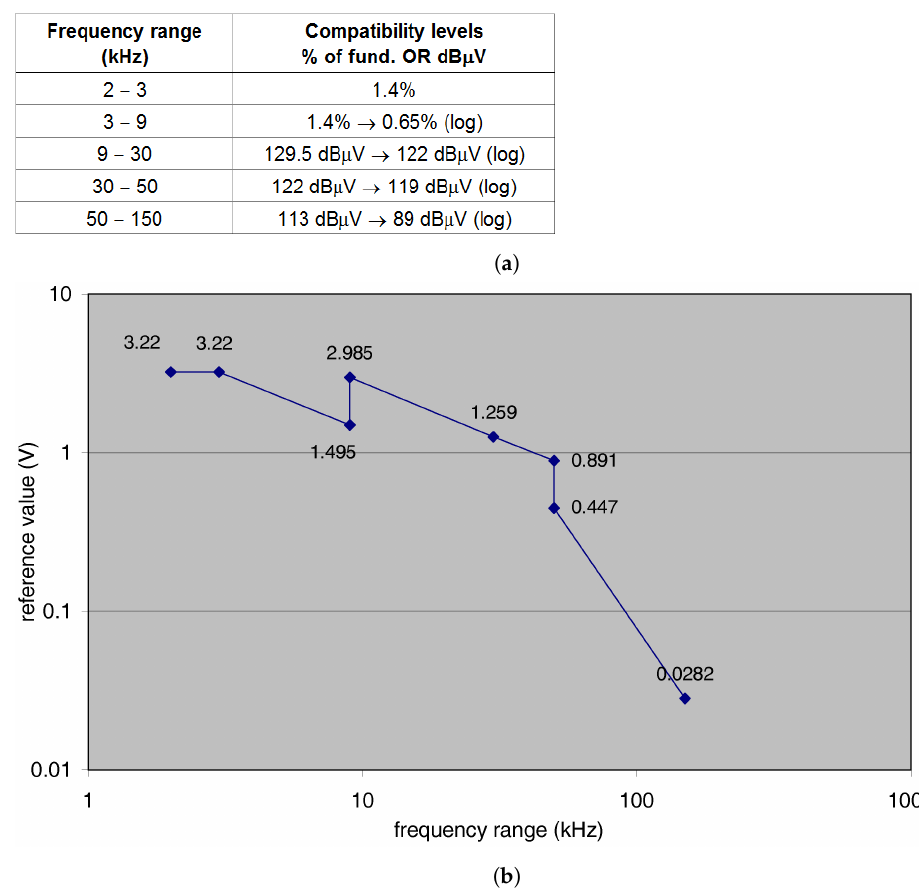
Figure 6. Supraharmonic distortion compatibility levels for public LV distribution grid (Table 2 of IEC 61000-2-2): ( a ) numeric values, ( b ) graphical